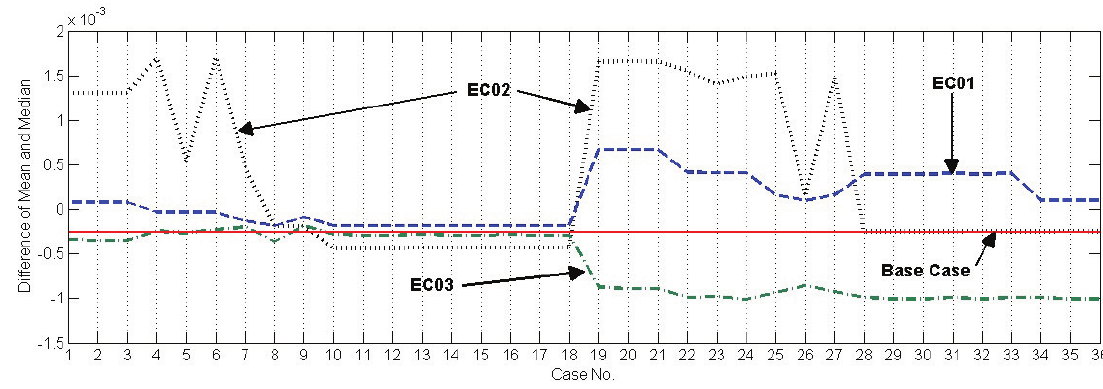
Figure 11. Difference between voltage mean and median in the FirstEnergy transmission